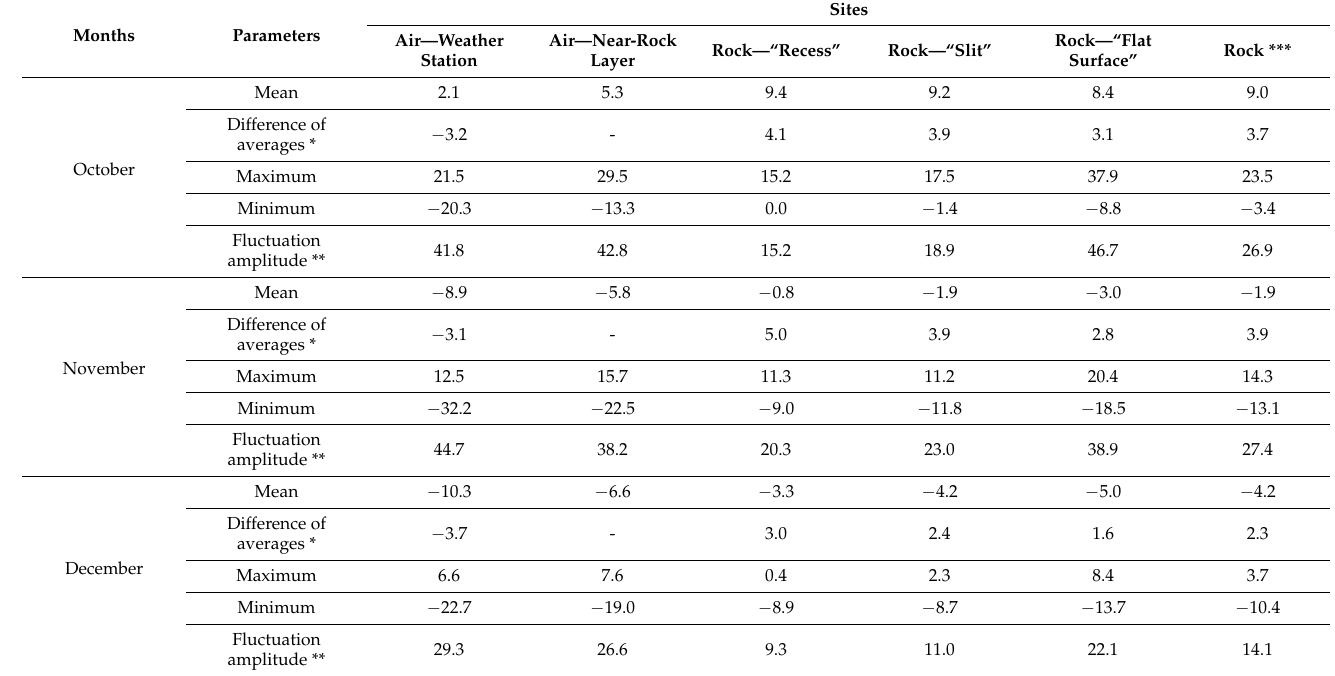
Table 1. Monthly temperatures in the main microhabitats in 2019.